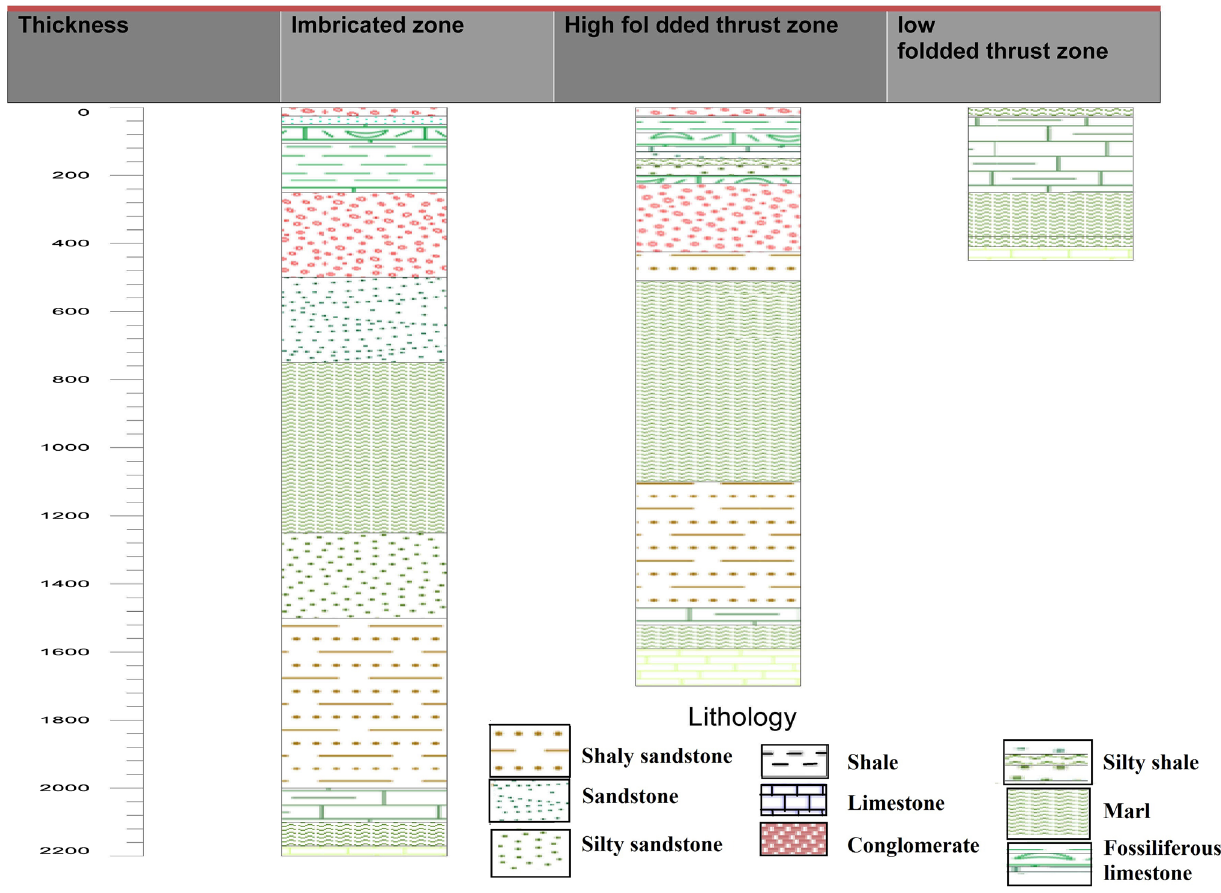
Fig. 2 Lithostratigraphic correlation of the Late Campanian–Late Maastrichtian in Kurdistan foreland